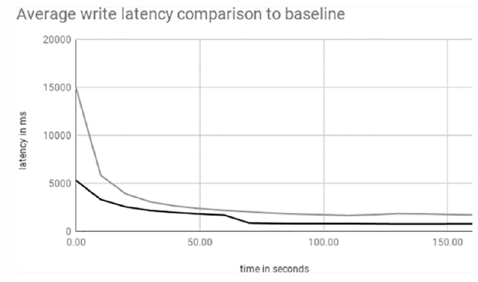
Figure 20. Average write latency of scaled cluster versus the baseline, single shard